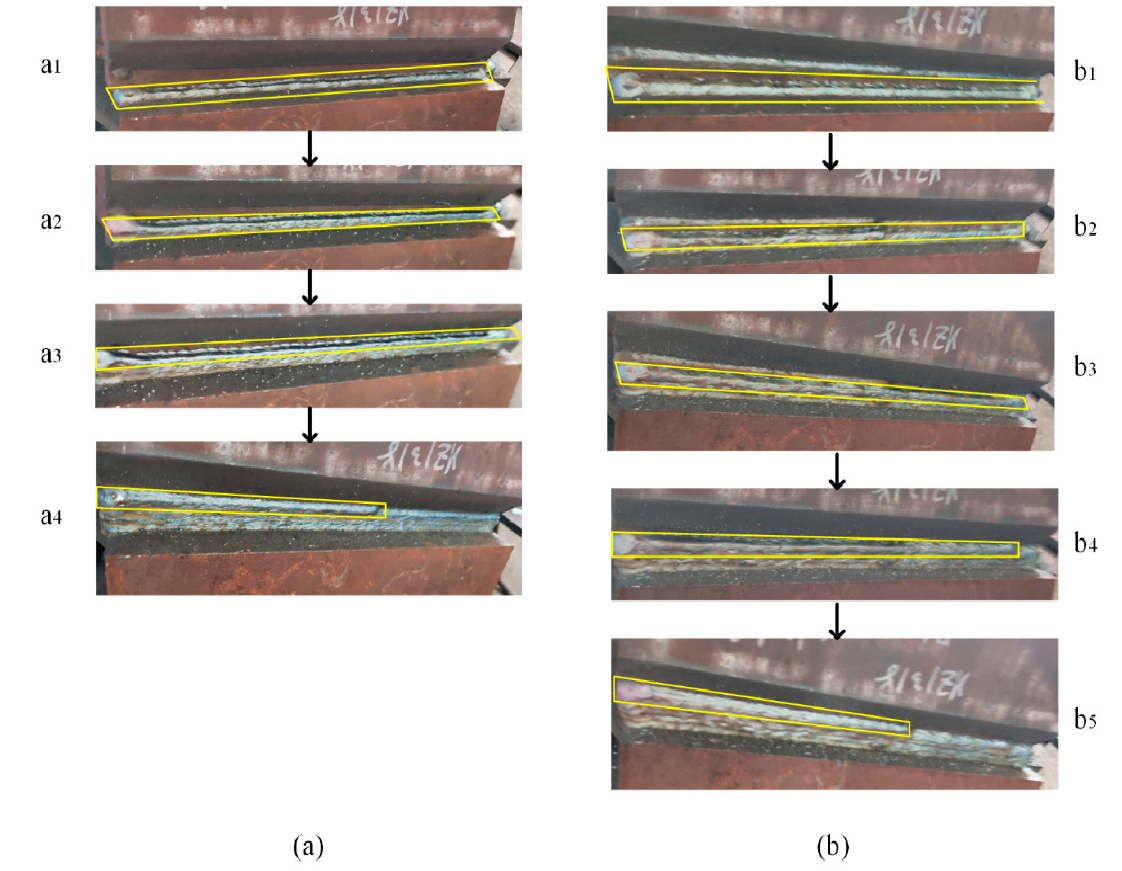
Figure 22. ( a ) The first layer welding operation (the yellow-framed part is the current weld bead); ( b ) The second layer welding operation.